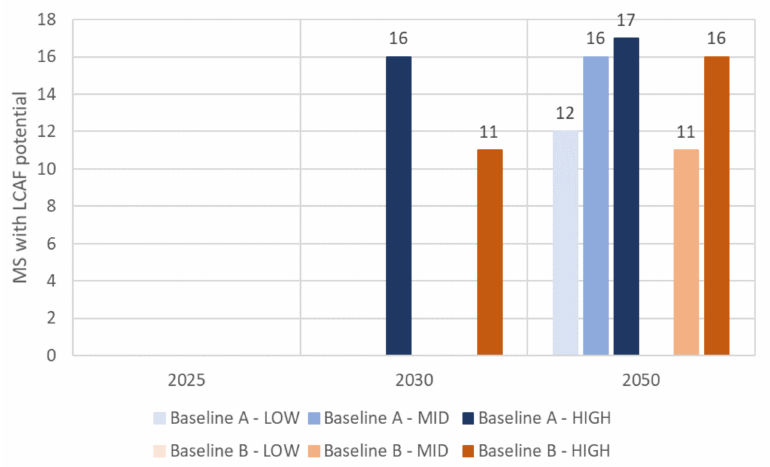
Figure 5. MS exhibiting LCAF potential. Calculated using free-allocation